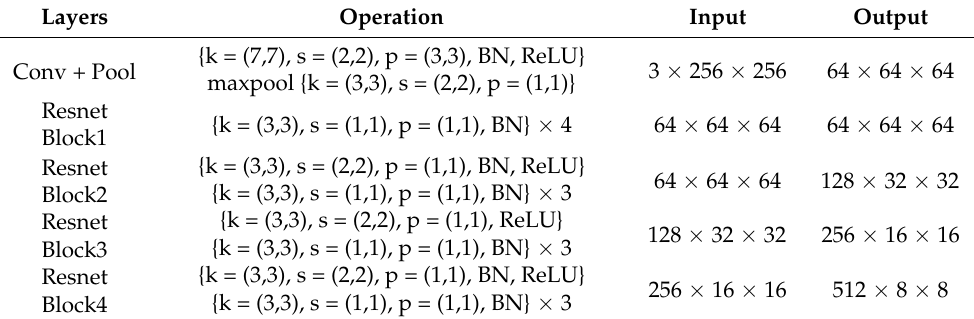
Figure 1. Framework of the CANet network. Table 1. Operation of backbone.